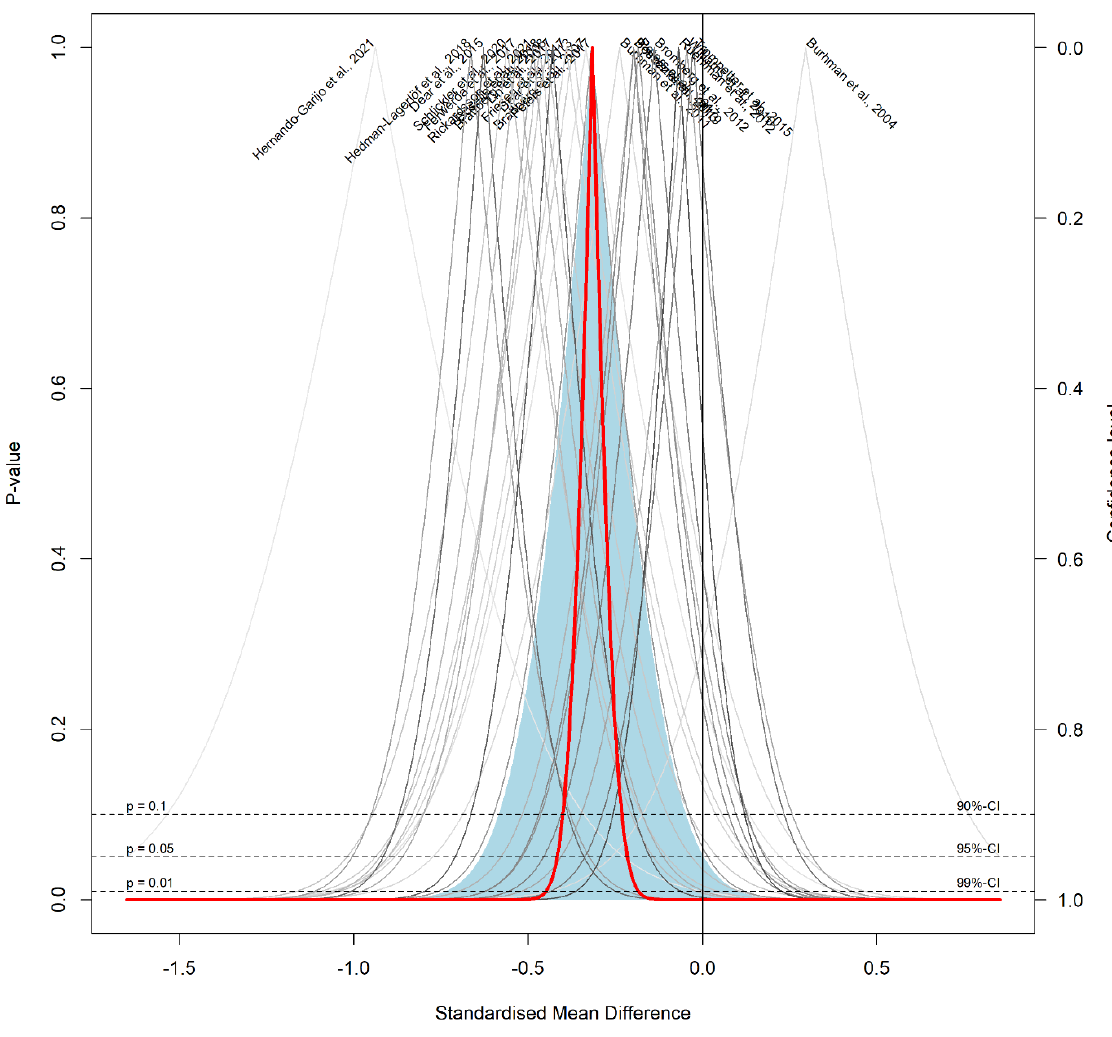
Figure A16. Drapery plot of the studies included in the sensitivity analysis.